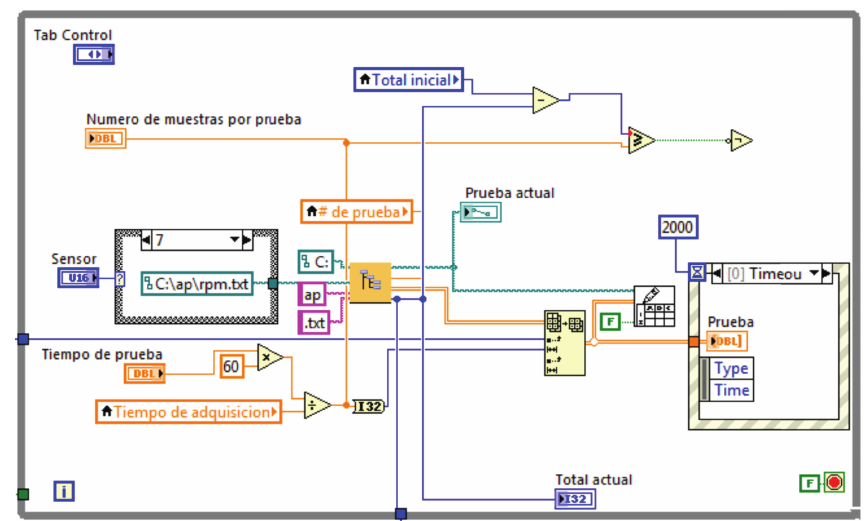
Figure 13: While loop 1 programming block.